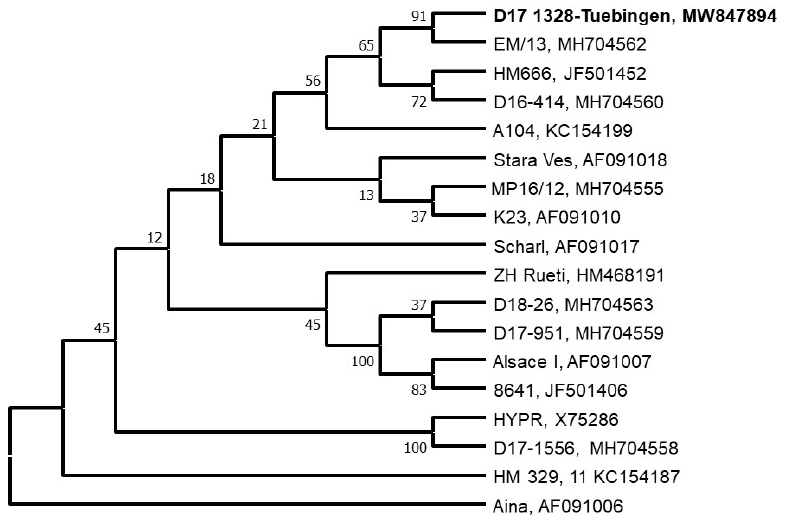
Figure 2. Maximum-likelihood-Analysis of E-Gen of the TBEV-EU isolate of the milk outbreak. The isolate of the outbreak (“Tübingen”) is shown in